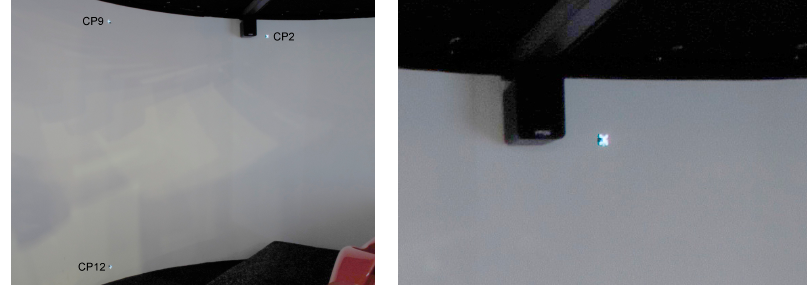
Figure 7. Projecting on top of the physical CPs ( right ) and detail of CP2 ( left ).